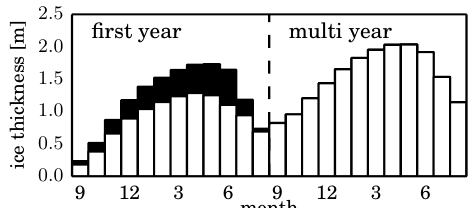
Figure 13. The white columns show the thickness of all monthly mean salinity profiles shown in Fig. 12. The black columns repre- sent only first-year ice which evolves into multiyear ice the follow- ing year. To be included in the monthly average ice must be present, meaning that model output of ice-free water with an ice thickness of zero is excluded from the